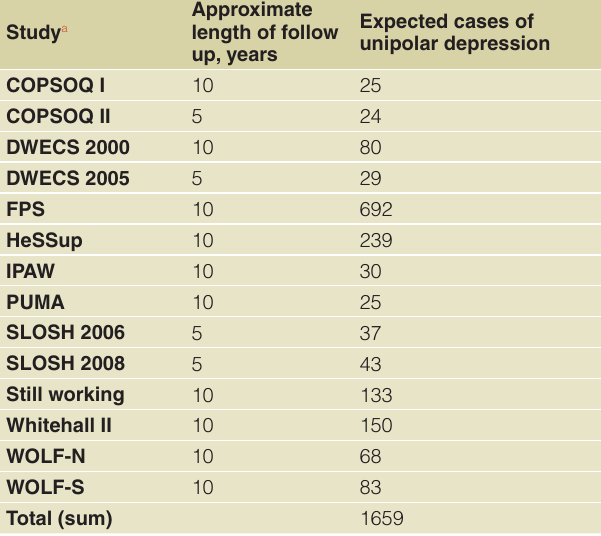
Table 4. Study-specific expected number of hospital diagnosed cases of unipolar